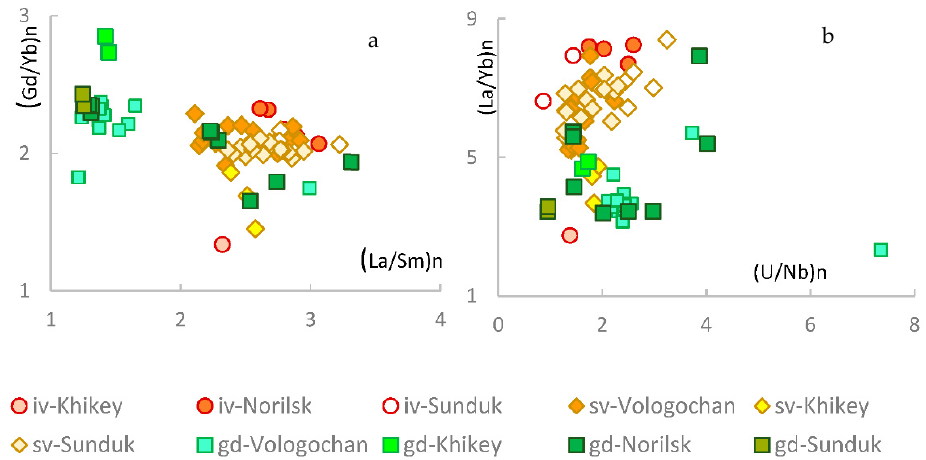
Figure 10. Diagrams (La/Sm)n vs. (Gd/Yb)n ( a ) and (U/Nb)n vs. (La/Yb)n ( b ) for the Ivakinsky, Syverminsky, and Gudchikhinsky Formations.